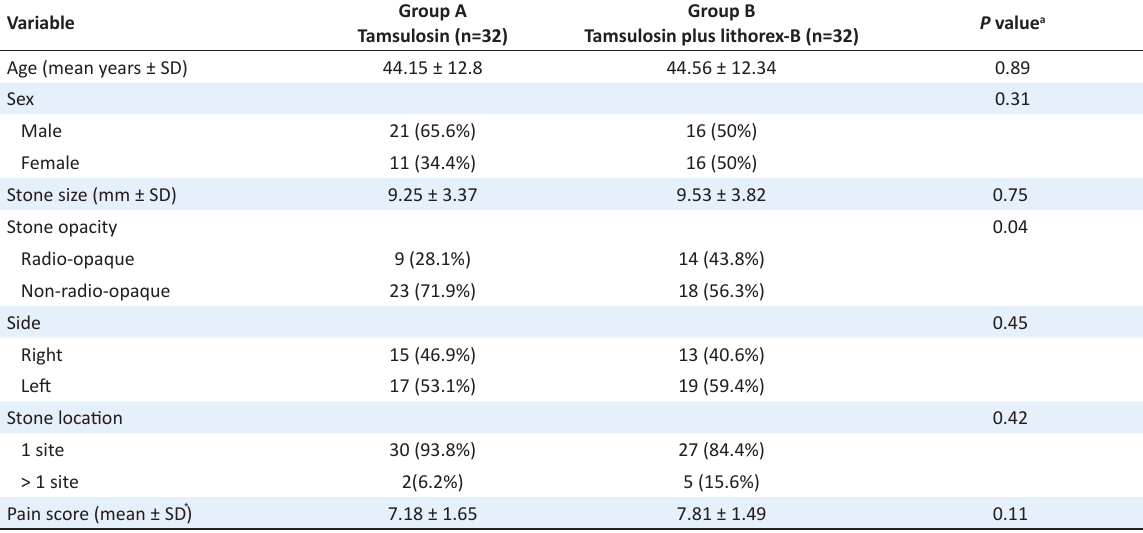
Table 1. Baseline demographic and clinical characteristics of